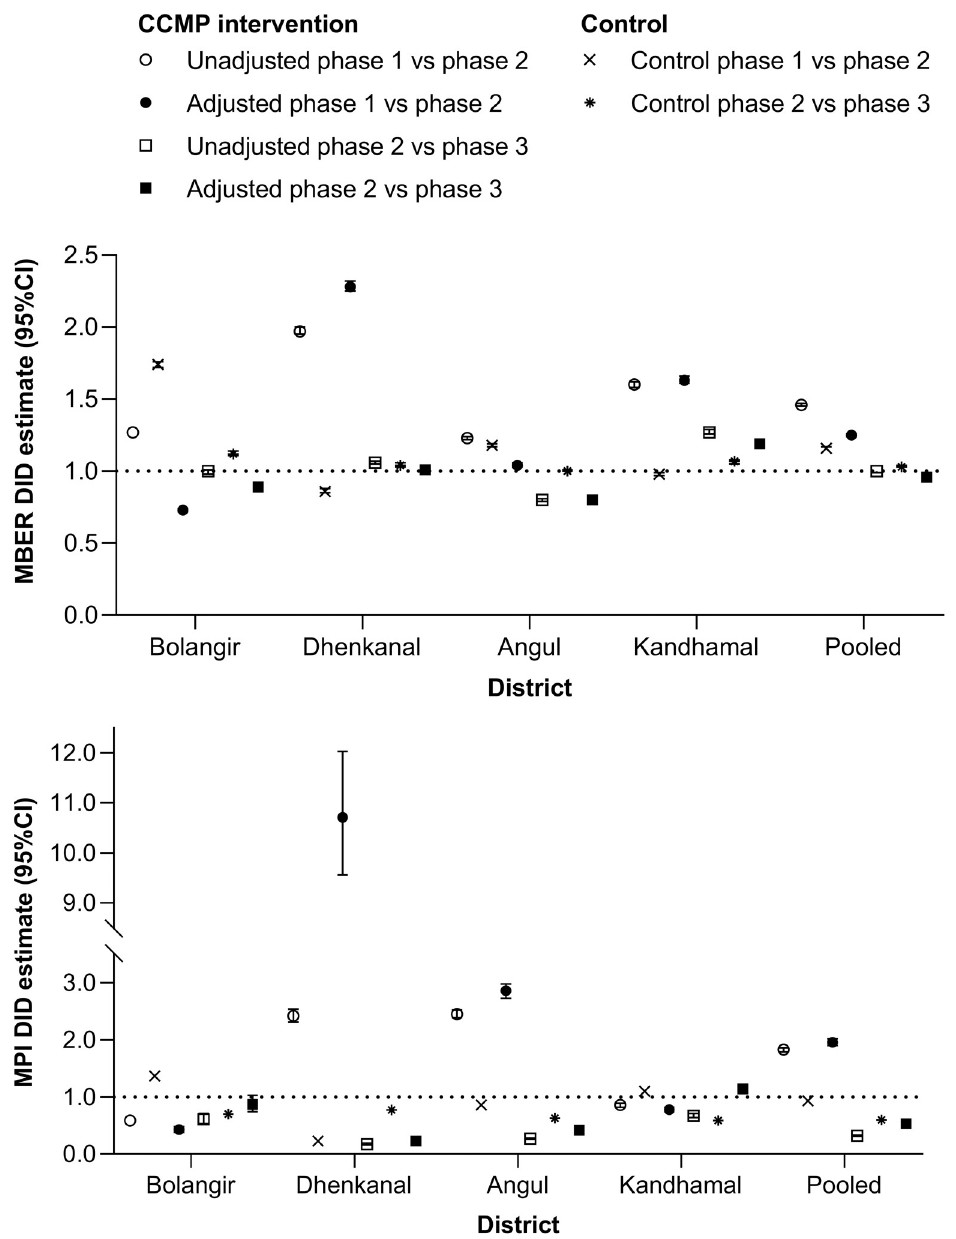
Fig 2. Difference-in-difference (DID) estimates for MBER and MPI in CCMP intervention blocks. Data are shown as CCMP intervention block unadjusted values and adjusted for contemporaneous changes in the control blocks; a value of 1 indicates no change, less than 1 is a decrease and more than 1 represents an increase. CCMP, Comprehensive Case Management Project; MBER, monthly blood examination rate = total number of slides examined in a month x1000 / total population; MPI, monthly parasite index = total number of positive slides for parasite in a month x1000 / total population. which remained steady, and strongly for MPI (Fig 1). Thus, although the investigation of malaria cases remained similar post-intervention versus during CCMP, the malaria case iden- tification rate declined, suggesting a reduction in malaria prevalence.